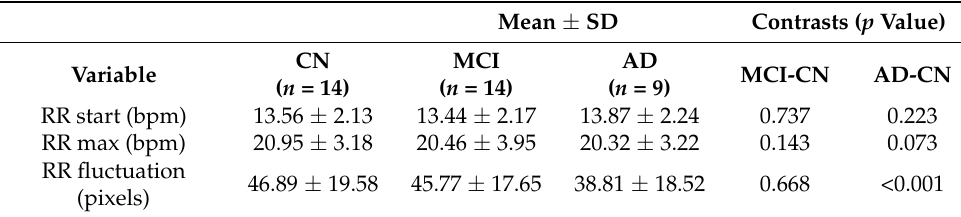
Table 2. Intention-to-treat groups: ANOVA results of baseline Respiration rate-start, -maximum and -fluctuation between CN, MCI and AD. Mean ± SD Contrasts ( p Value) CN Variable ( n = 14)